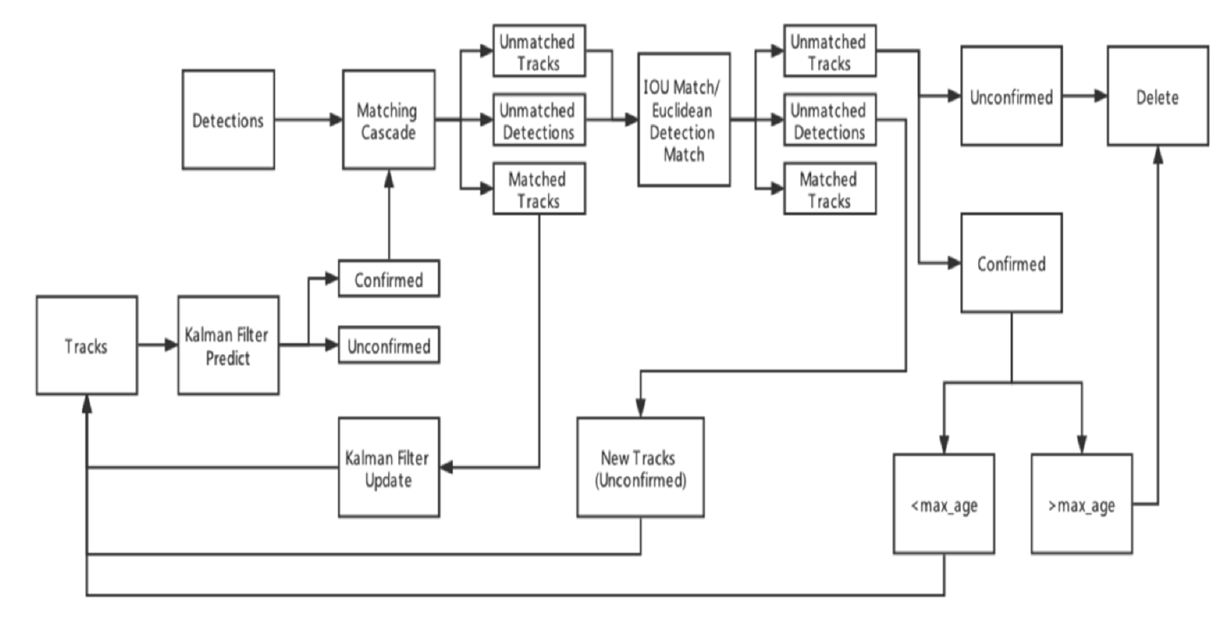
Figure 7. Improved DeepSORT structure.